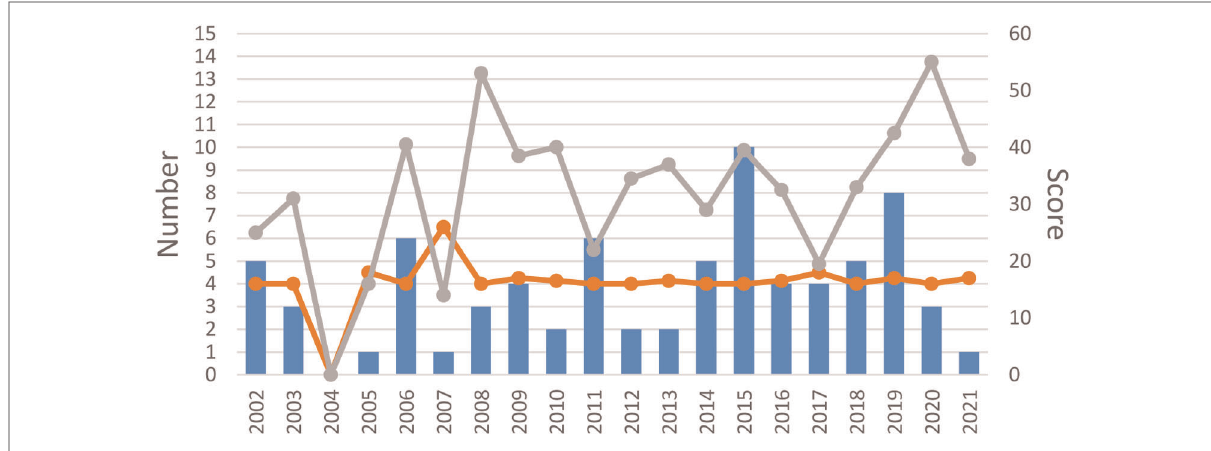
FIGURE 2 Year of publication. The blue bar is the number of RCTs published each year. The orange line is the median OQS with CONSORT statement of each year. The gray line is the median OQS with STRICTA statement of each